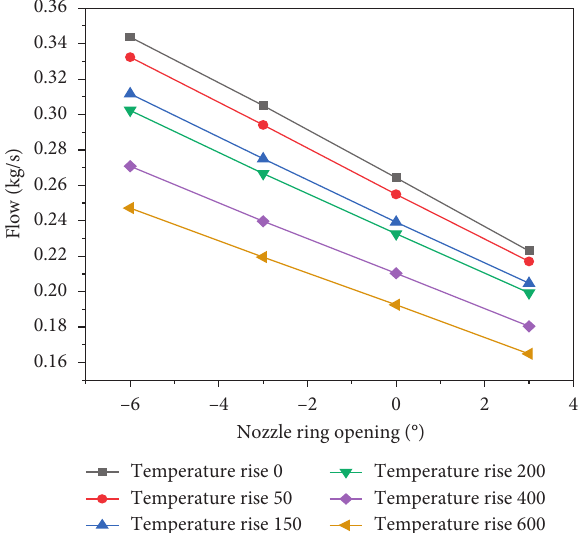
Figure 37: Relationship between opening and power.